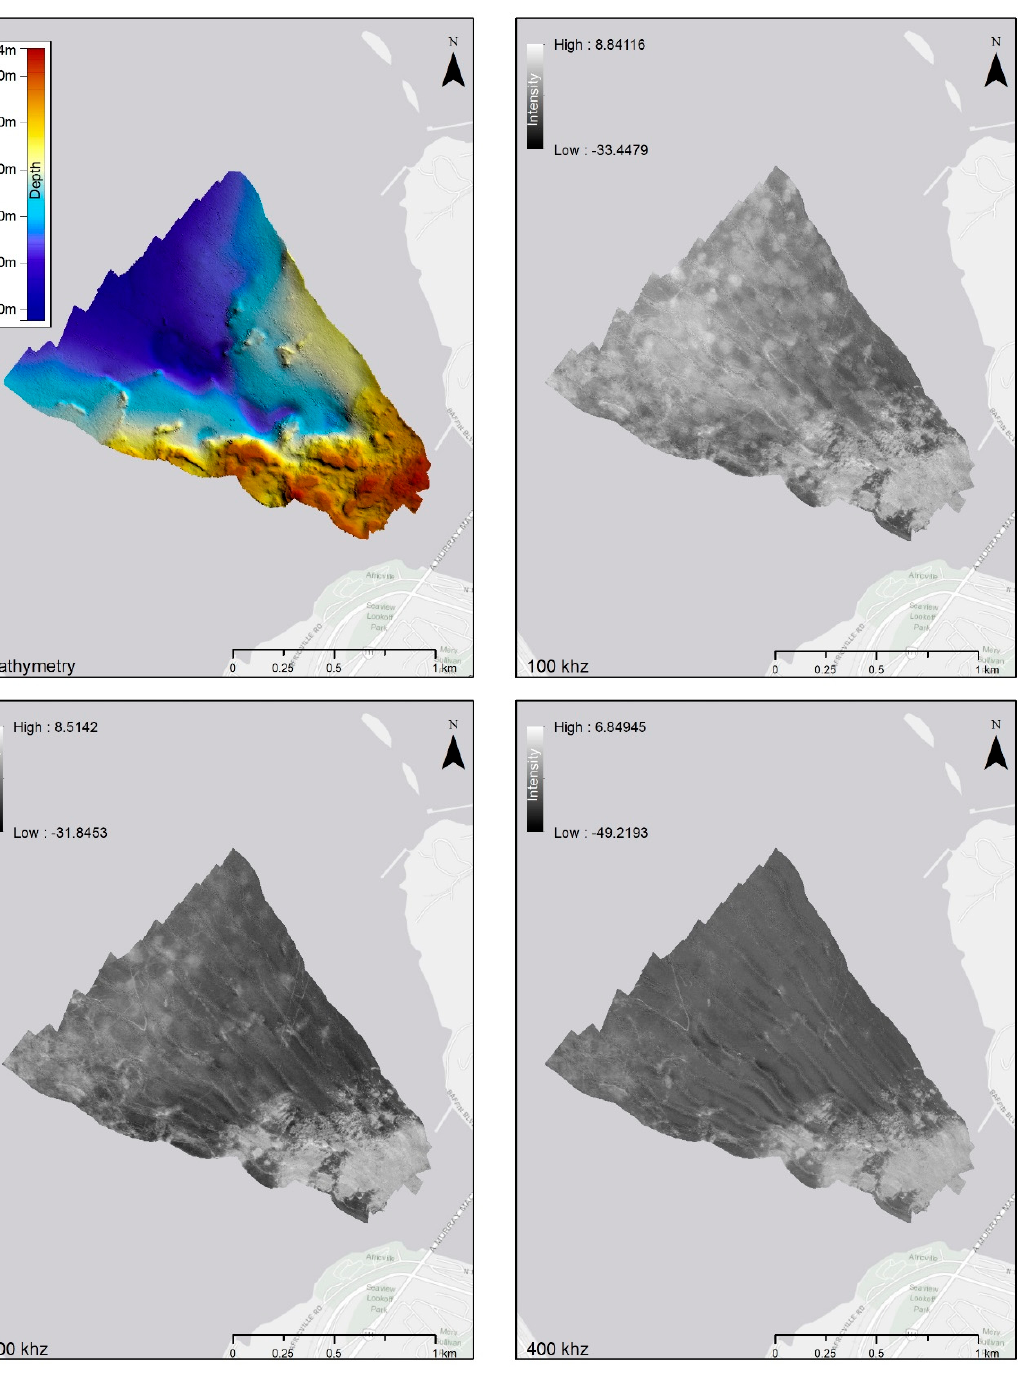
Figure 4. 2016 multibeam echosounders (MBES) bathymetry and multispectral backscatter: 100 kHz, 200 kHz, and 400 kHz mosaics.